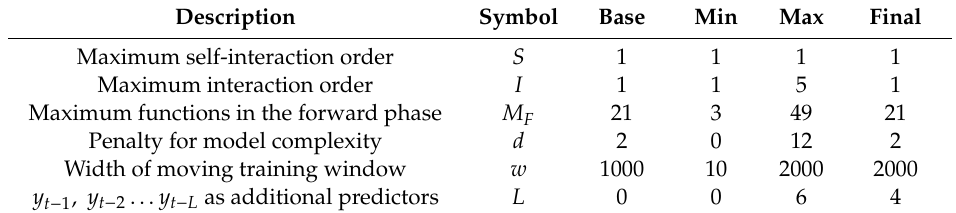
Table 2. Model hyperparameters with their initial values, explored ranges, and final configuration. Description Symbol Base Min Max Final Maximum self-interaction order Maximum functions in the forward